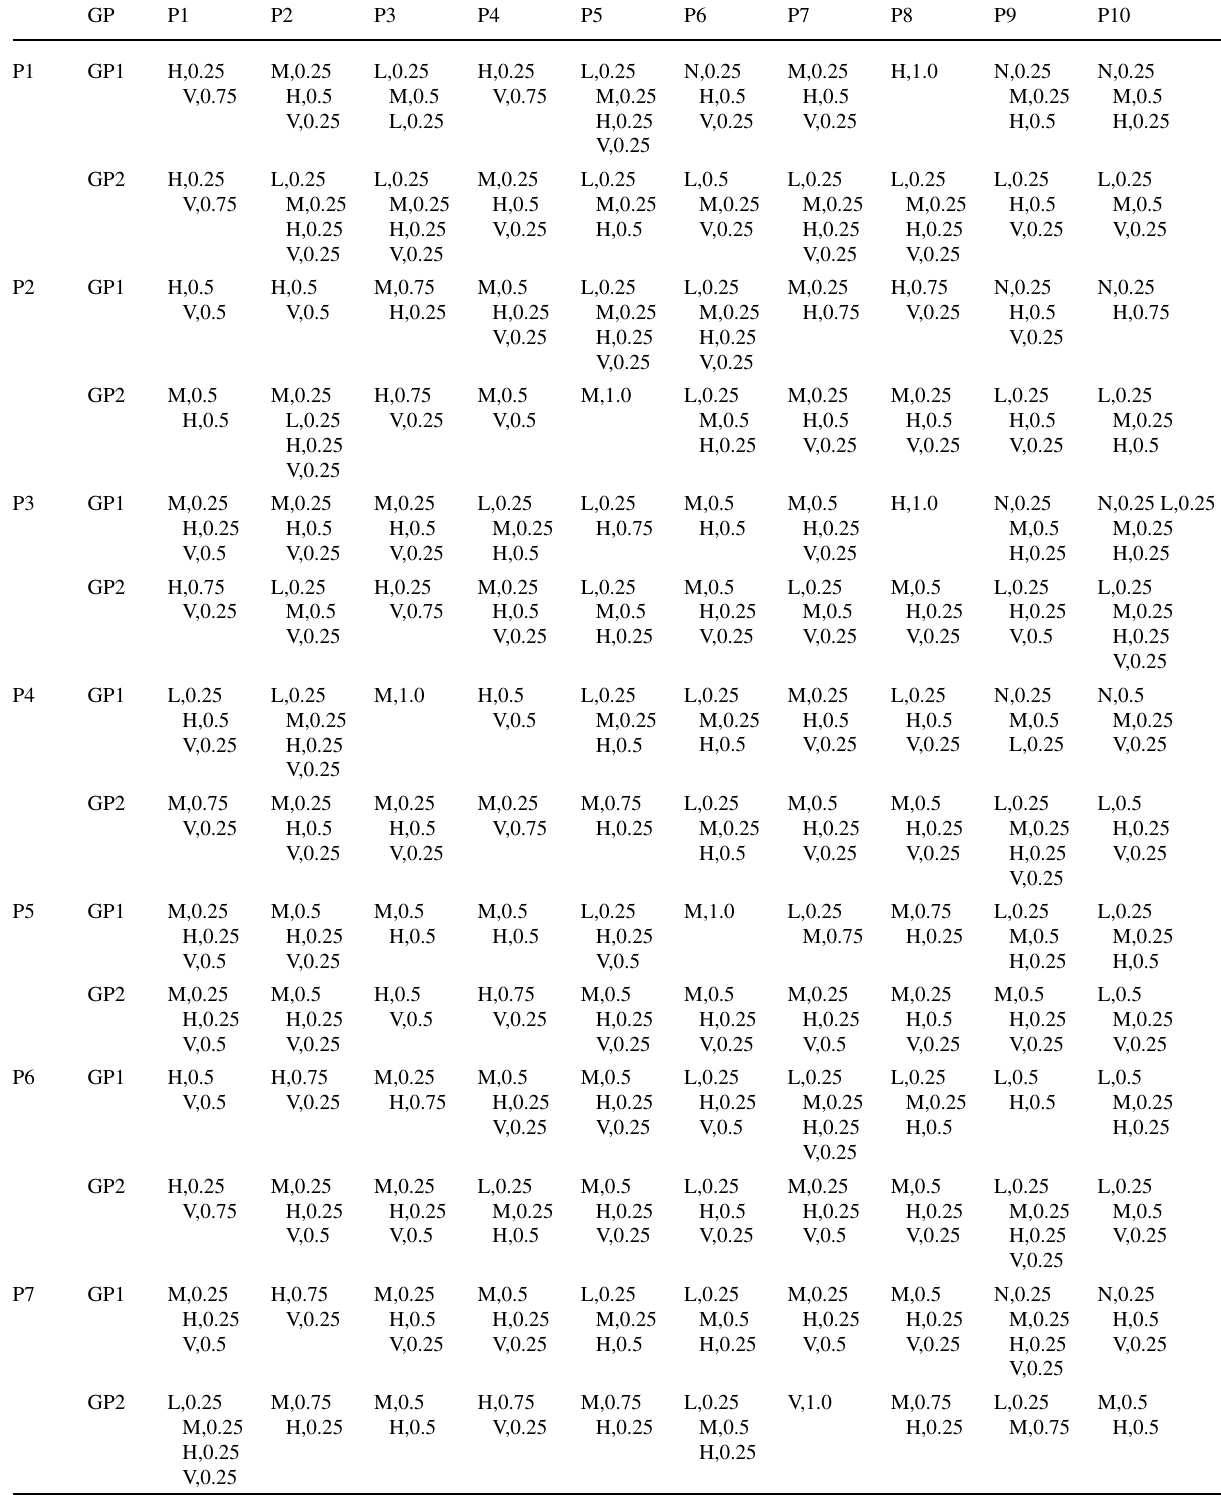
Table 3 Group experts’